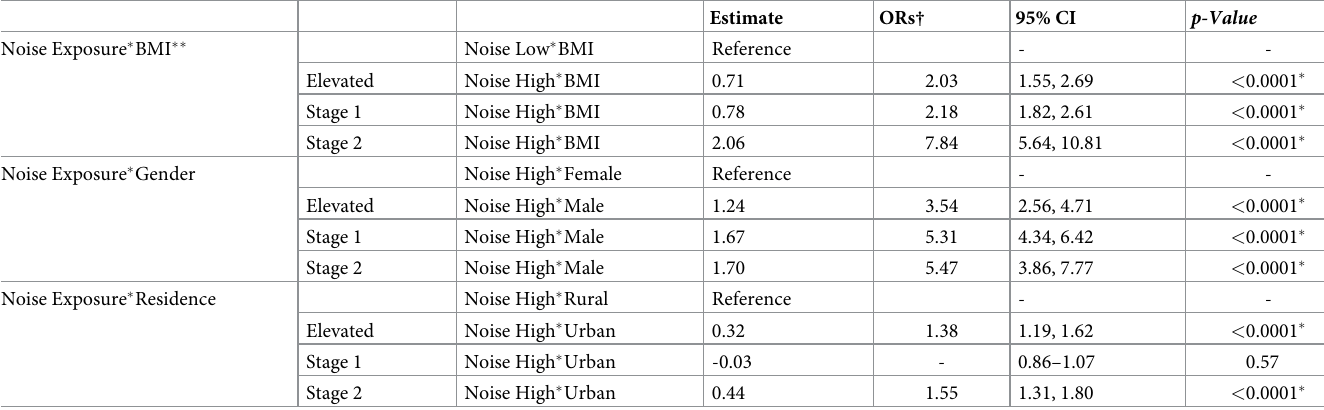
Table 6. Logistic model for association between noise exposure-BMI, -gender, and -residence interaction and blood